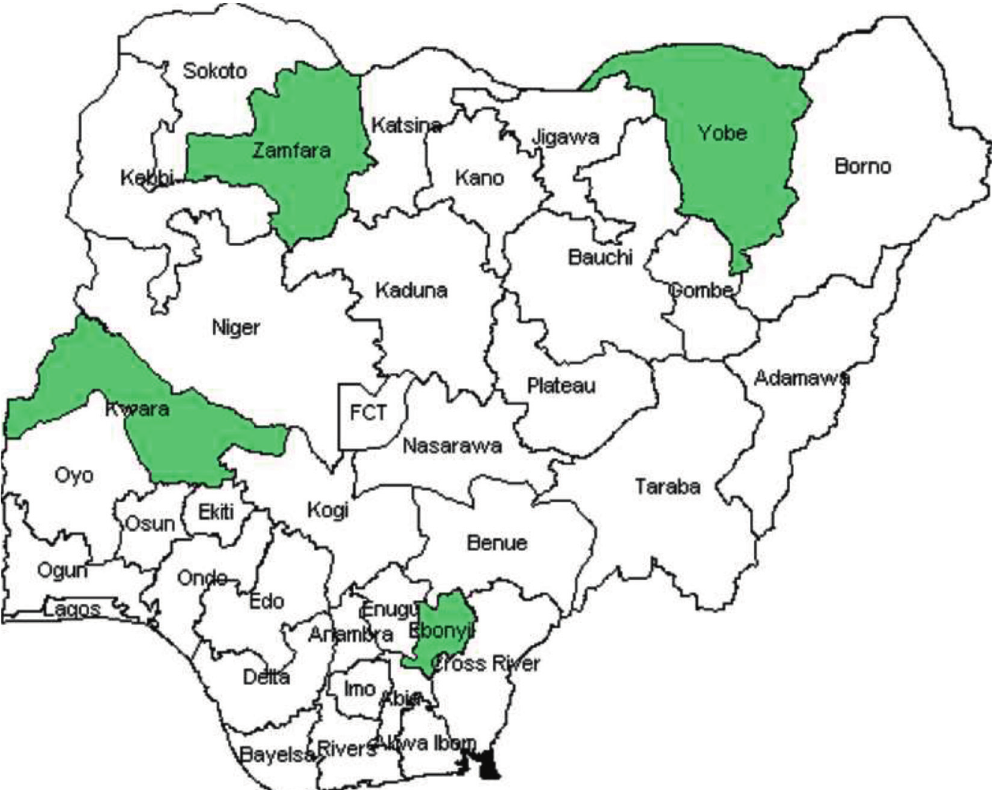
Figure 1: ITN coverage in Nigeria.